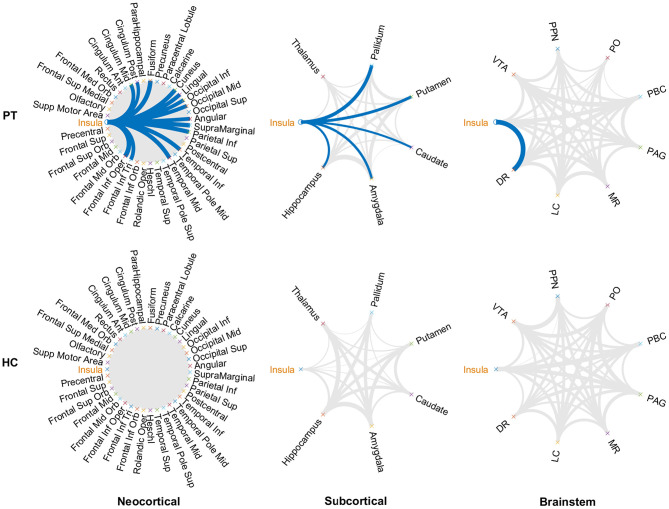
Insula-to-cortex metabolic covariance network for a group of individuals with insular epilepsy (upper panel) and a group of healthy individuals (lower panel). Networks stratified according to neocortical (left), subcortical (center), and brainstem (right) regions. Line thickness is modulated by the correlation coefficient, and connections that survive correction for multiple comparisons across the set of all connections are indicated in blue (P < 0.05, Bonferroni corrected). While FDG uptake values in the epileptic group were significantly correlated between the insula and numerous regions of the neocortical, subcortical, and brainstem structures, no such associations were evident in the healthy group. DR, dorsal raphé; LC, locus coeruleus; MR, median raphe; PAG, periaqueductal gray; PBC, parabrachial complex; PO, pontis oralis; PPN, pedunculopontine nucleus; VTA, ventral tegmental area.